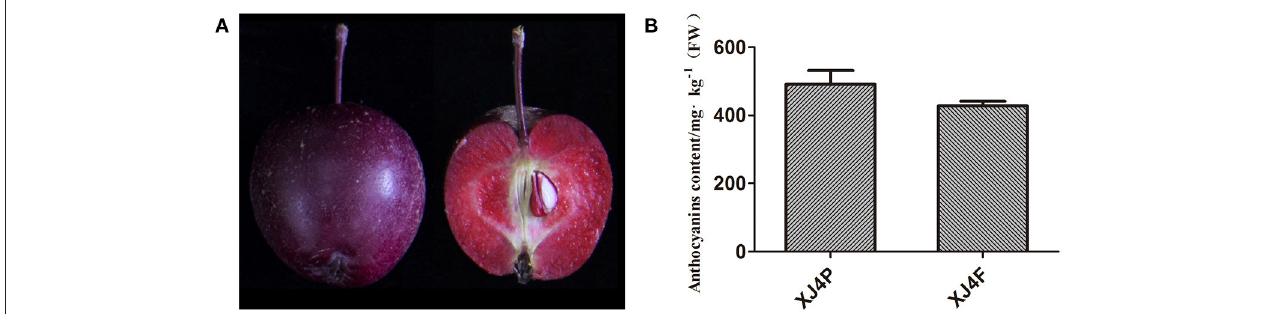
FIGURE 1 | Phenotypic characteristics and anthocyanin content of red-fleshed apple variety “XJ4.” (A) Intact fruit and longitudinal section of “XJ4” to show peel and flesh. (B) Anthocyanin content of “XJ4” peel and flesh. XJ4P and XJ4F represent peel and flesh of “XJ4,” respectively.